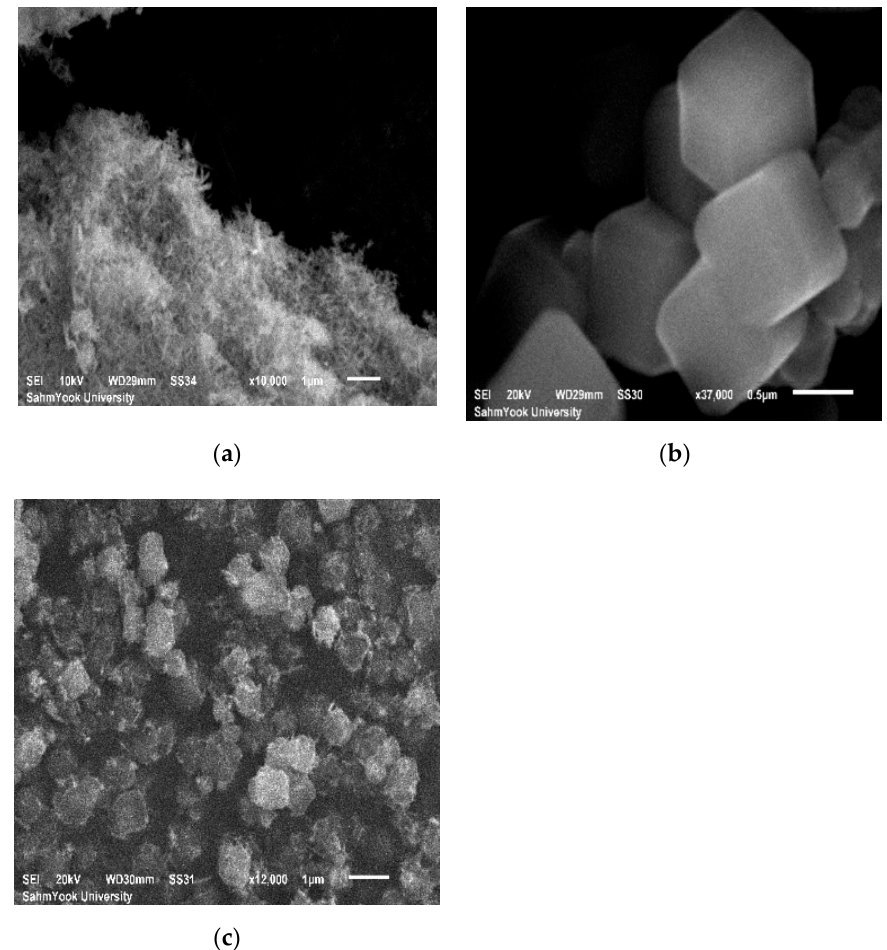
Figure 3. SEM images of ( a ) Gd 2 O 3 nanowires, ( b ) ZIF-8, and ( c ) Gd 2 O 3 -ZIF-8